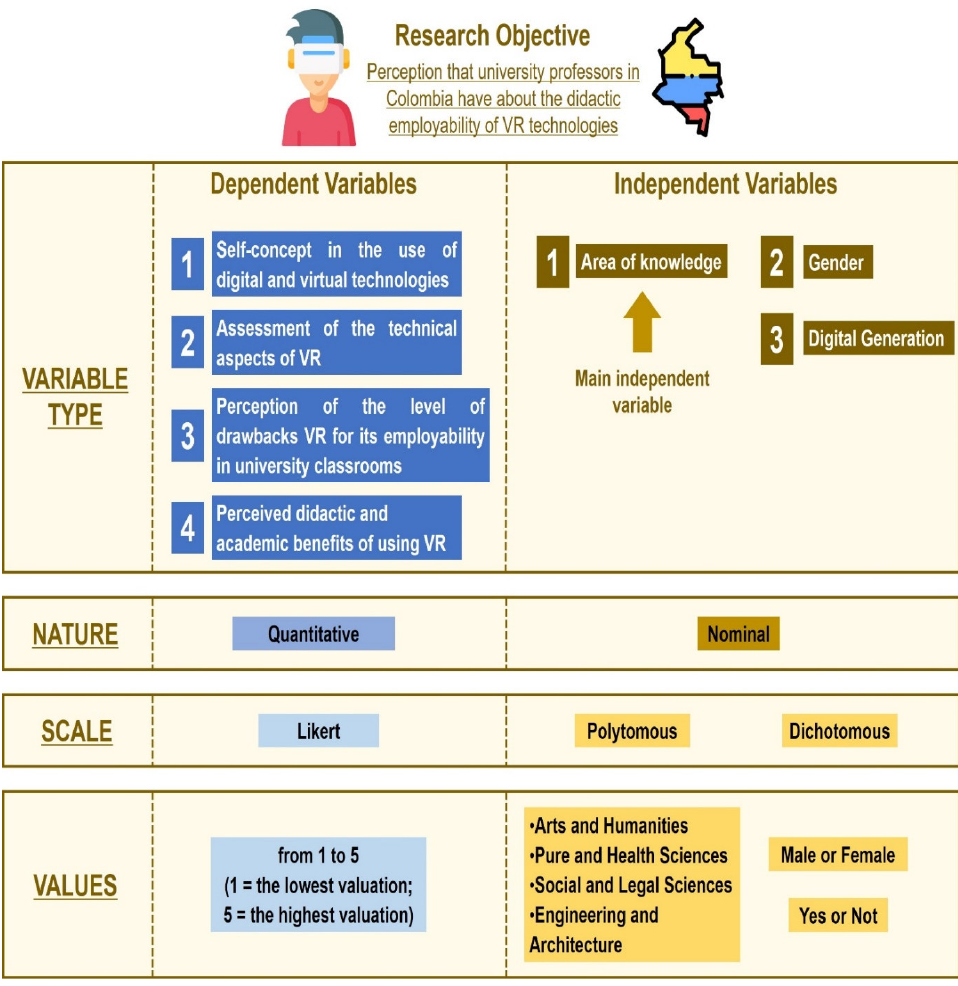
Figure 2. Variables considered in this